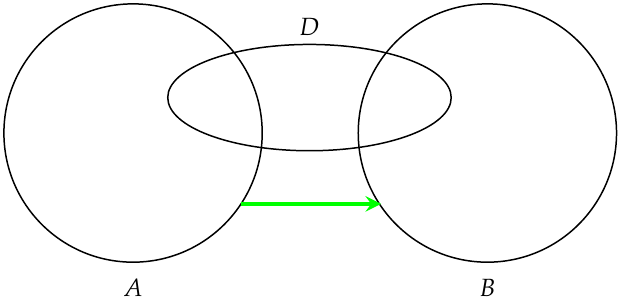
Figure 5. Bird’s perspective representation of uf 20 − 01. cnf using A = V ( N ( M )) and B = P ( M ) , where M is a solution of uf 20 − 01. cnf